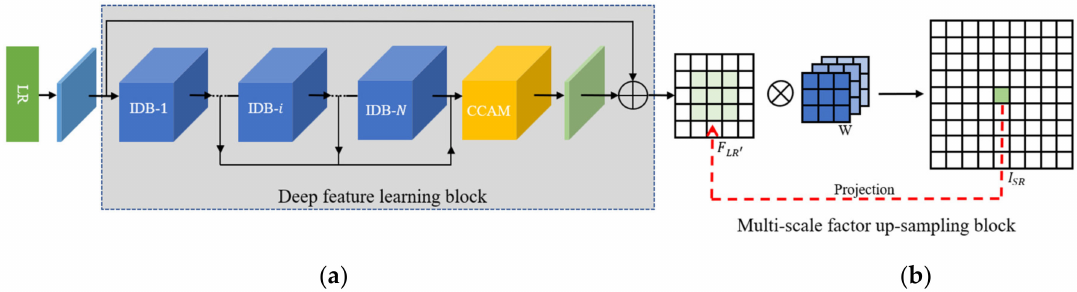
Figure 2. Network architecture of multi-factor image super-resolution based on information dis- tillation (IDMF-SR). ( a ) The blue box represents Conv-3; ( b ) The green box represents